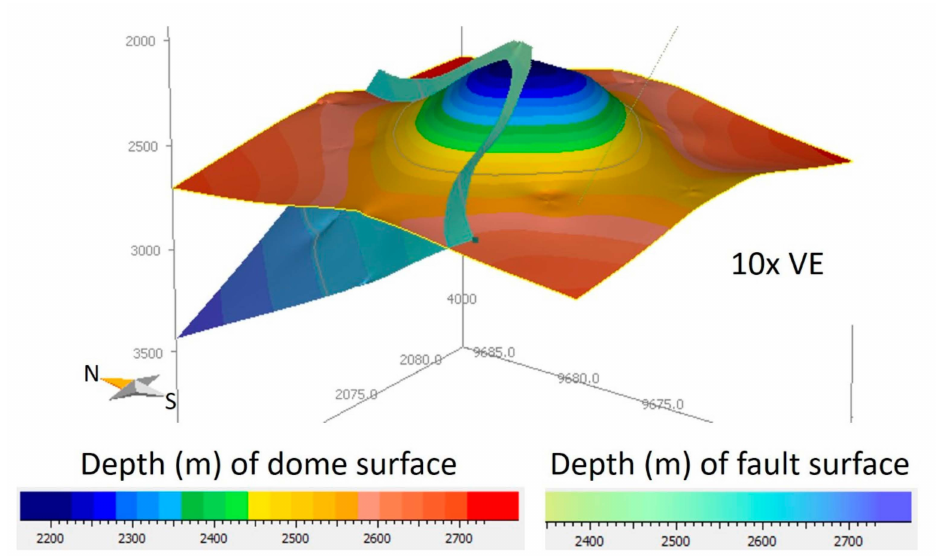
Figure 2. Structural features (anticlinal dome and fault plane) included within our 3-D synthetic model to create “geologically favorable” factors for the migration and accumulation of gas. Note 10 × vertical